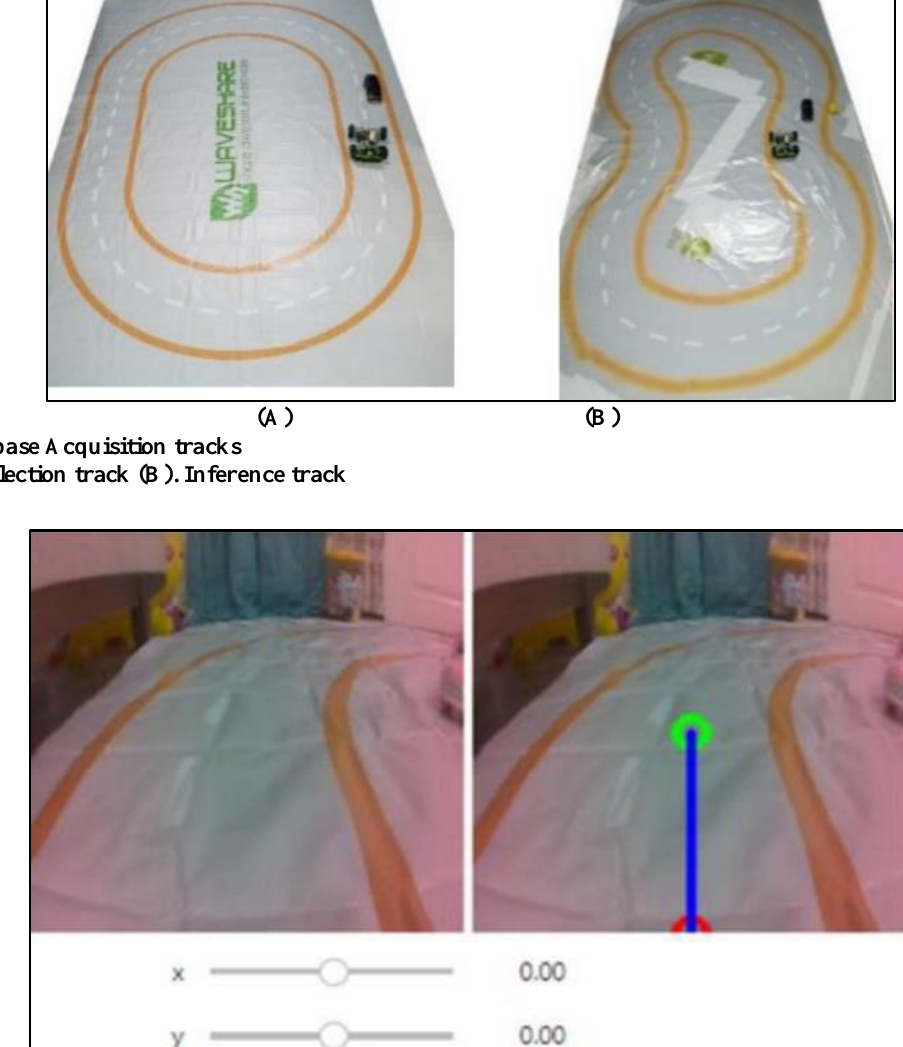
channels of RGB colors). The number of images increased to 1528 samples after data augmentation. The dataset was divided into two portions: 80% for